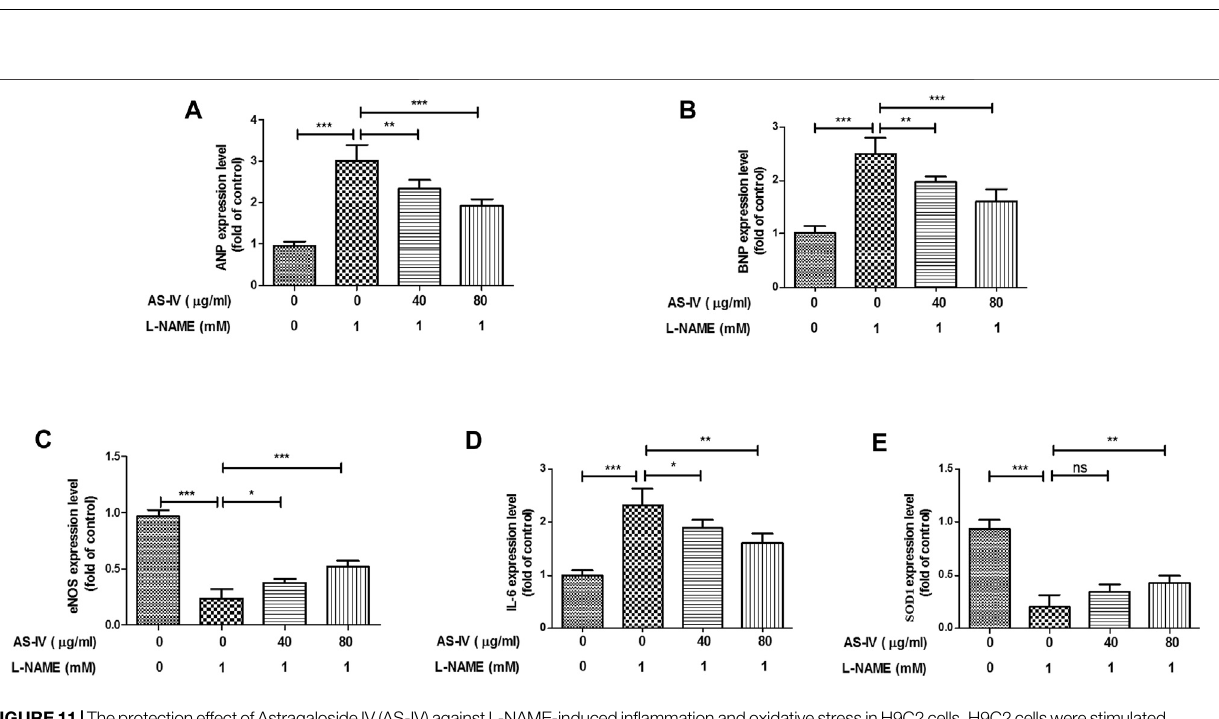
FIGURE10| EffectofAstragalosideIV(AS-IV)onthecellviabilityinL-NAME-stimulatedH9C2cells.H9C2cellswerestimulatedwithdifferentconcentrationsofAS- IV (20, 40, and 80 μ g/ml) in the absence or presence of L-NAME (1 mM) for 24 h. Results were presented as mean ± standard deviation (SD). n (cid:1) 4. ** p < 0.01, *** p <